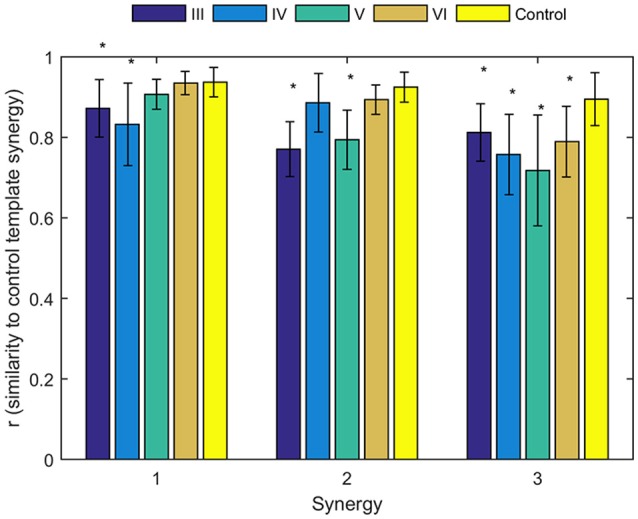
Similarities of synergies compared to control template. The average similarity of the synergies observed for individual subjects in each stroke and control group to the control template (*denotes a significant difference between group means; p < 0.05).